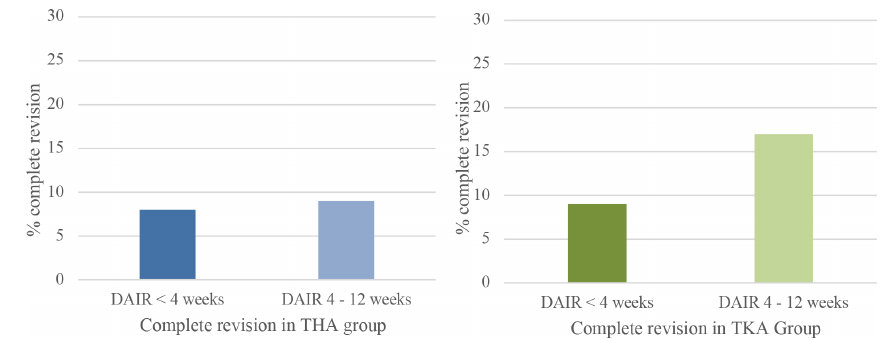
Figure 3. Percentage of complete revision within 1 year when DAIR is performed for acute postoperative PJI < 4 weeks after primary surgery or between 4 and 12 weeks. Blue graph for THA and green for